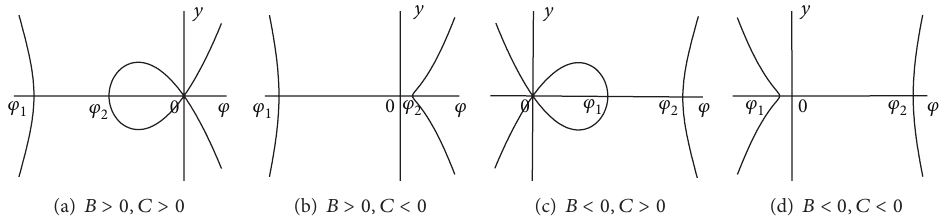
Figure 2: The bifurcation phase portraits of system (6) with 𝐴 > 0 .